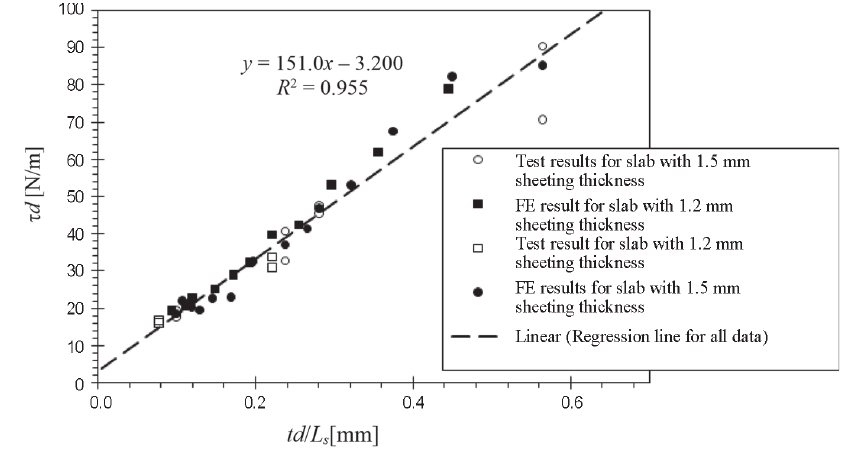
Fig. 9. τd versus td/L s for combined results for slabs on 76 mm deck and 1.2 mm and 1.5 mm sheeting thicknesses (FE models #1 – #27 of Table 2 and test data of specimens #1 – #9 of Table 1)